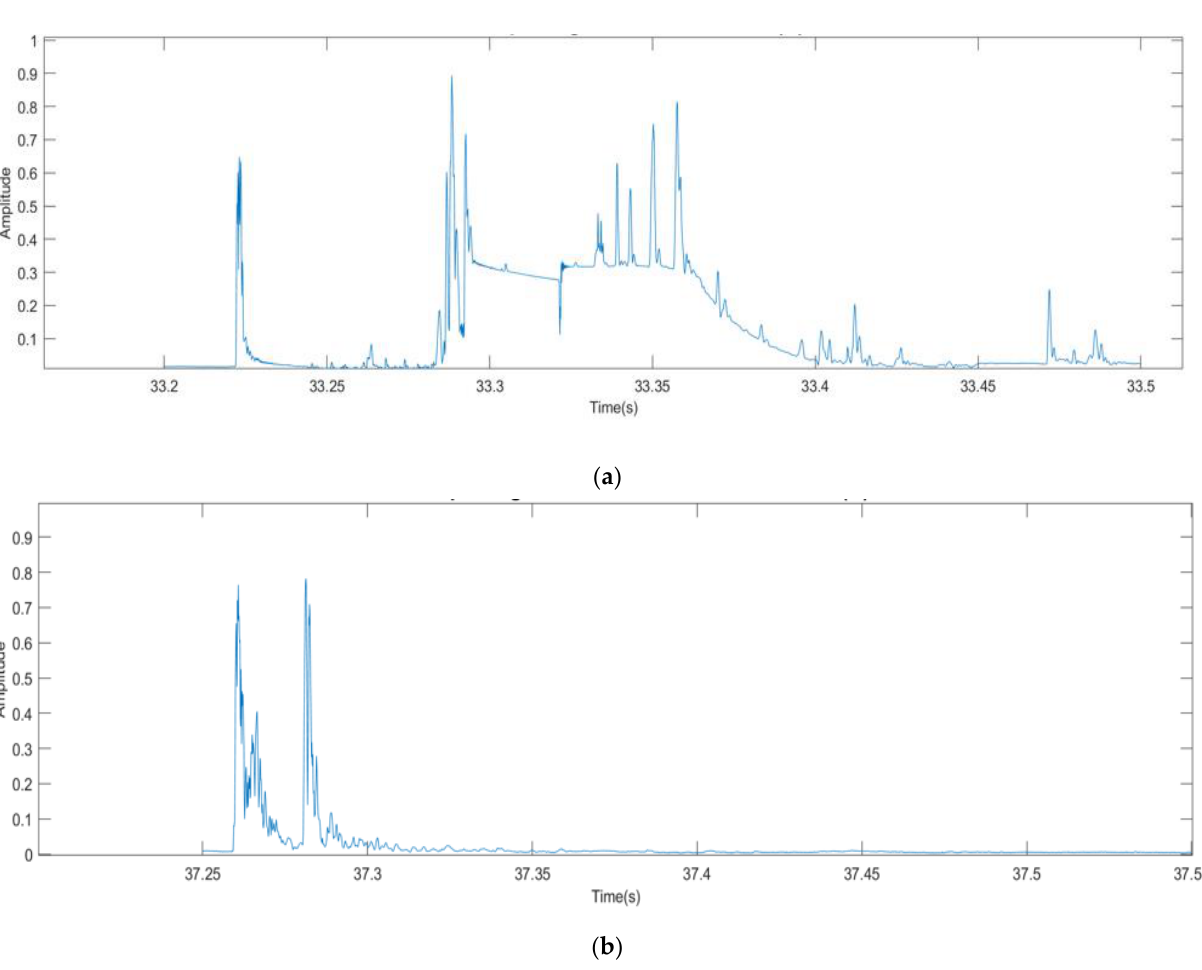
Figure 7. Root mean square (RMS) curves showing the range bars during the occurrence of macrocracks for: ( a ) plain SCC; and ( b ) SFRSCC beams.